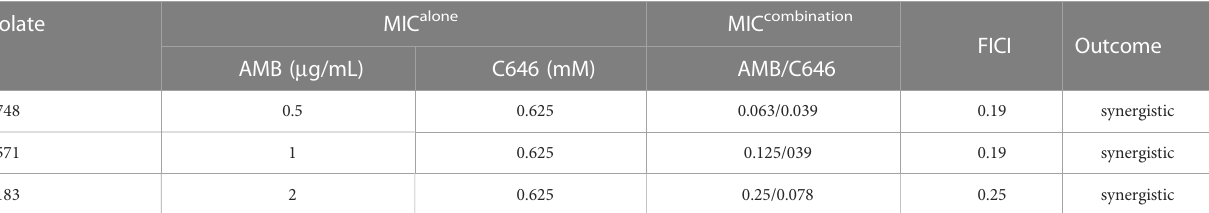
TABLE 1 Effect of C646 on the antifungal activity of AMB in C. krusei .